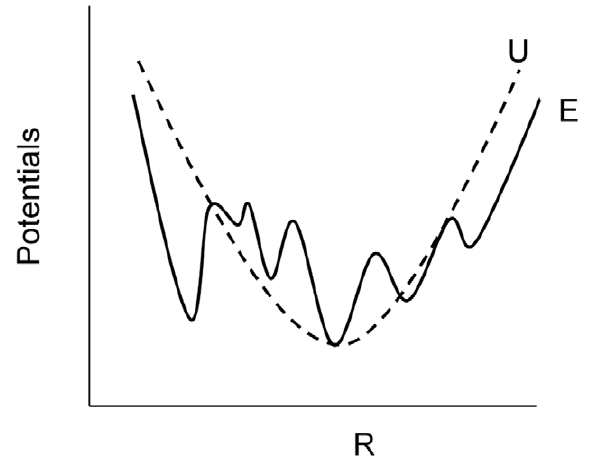
Figure 1. One dimensional schematic of potential energy surfaces. U is the harmonic CG potential; E is the protein’s true potential. Native values are subtracted from both.